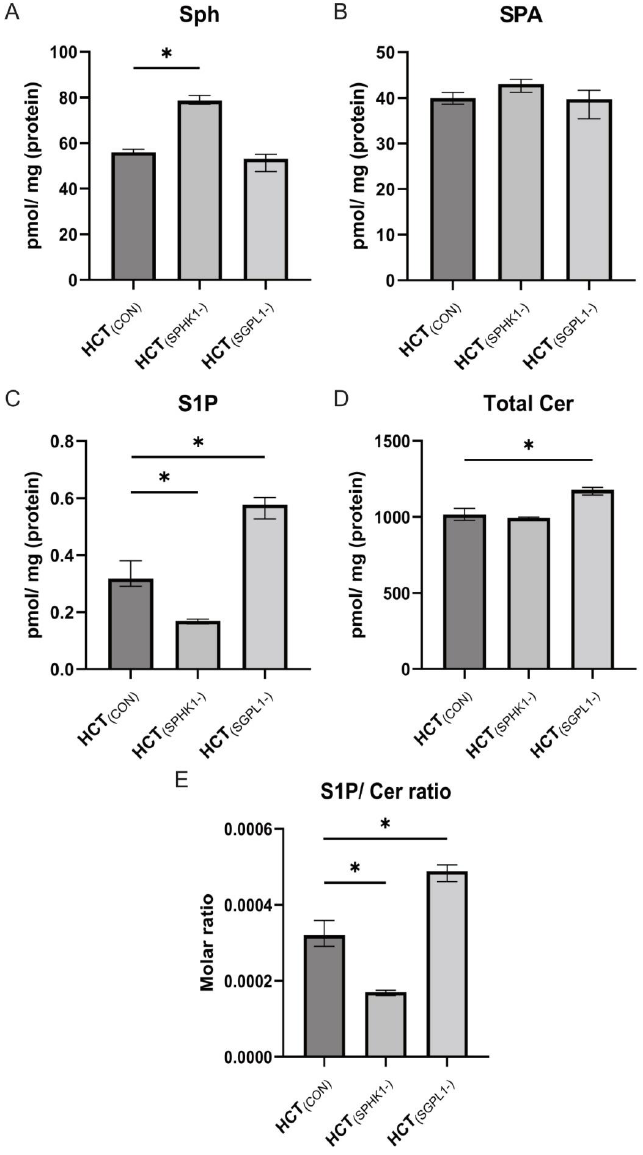
Figure 3. The effect of SPHK1 and SGPL1 silencing on the content of free sphingoid bases (Sph, SPA; panels A and B ), sphingosine-1-phosphate (S1P, panel C ), total ceramide (panel D ) and S1P/Cer ratio (panel E ) in human colorectal carcinoma HCT-116 cells. The S1P/Cer ratio was normalized to control. Values are medians +/ − interquartile ranges (n = 4); * p < 0.05; vs. control (HCT (CON) ).